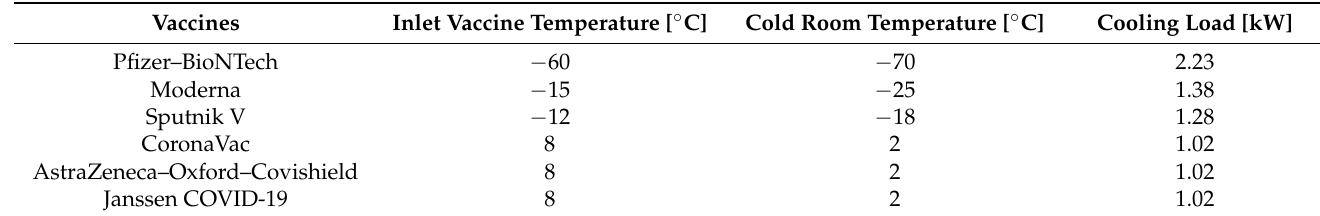
Table 3. Vaccines’ cooling